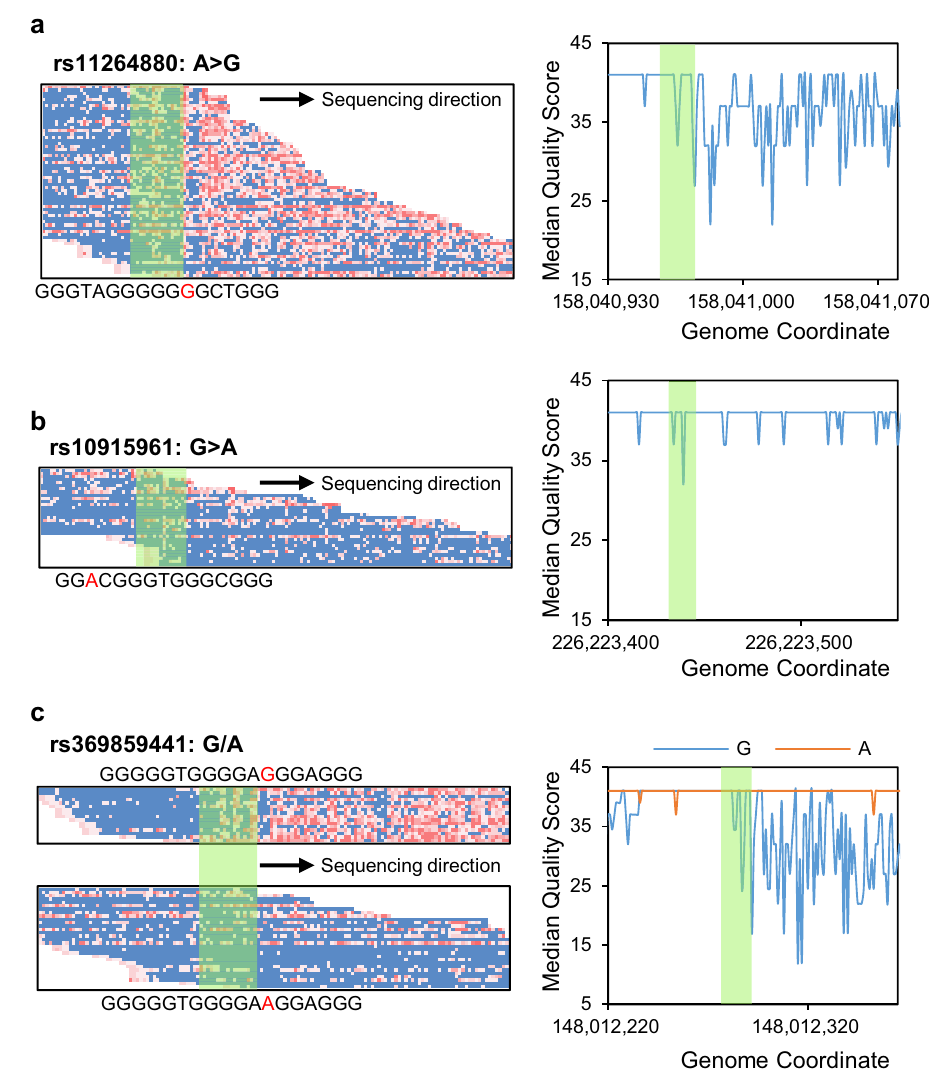
Fig. 5 In fl uence of SNVs in G4 formation. a The alteration of a homozygous SNV (rs11264880) causes the formation of a G4 structure and was detected.